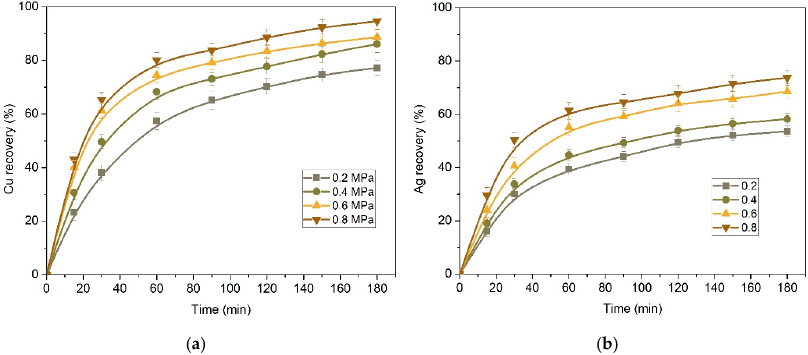
Figure 10. Dependence of Cu ( a ) and Ag ( b ) recovery on oxygen pressure and duration (temperature: 140 °C).